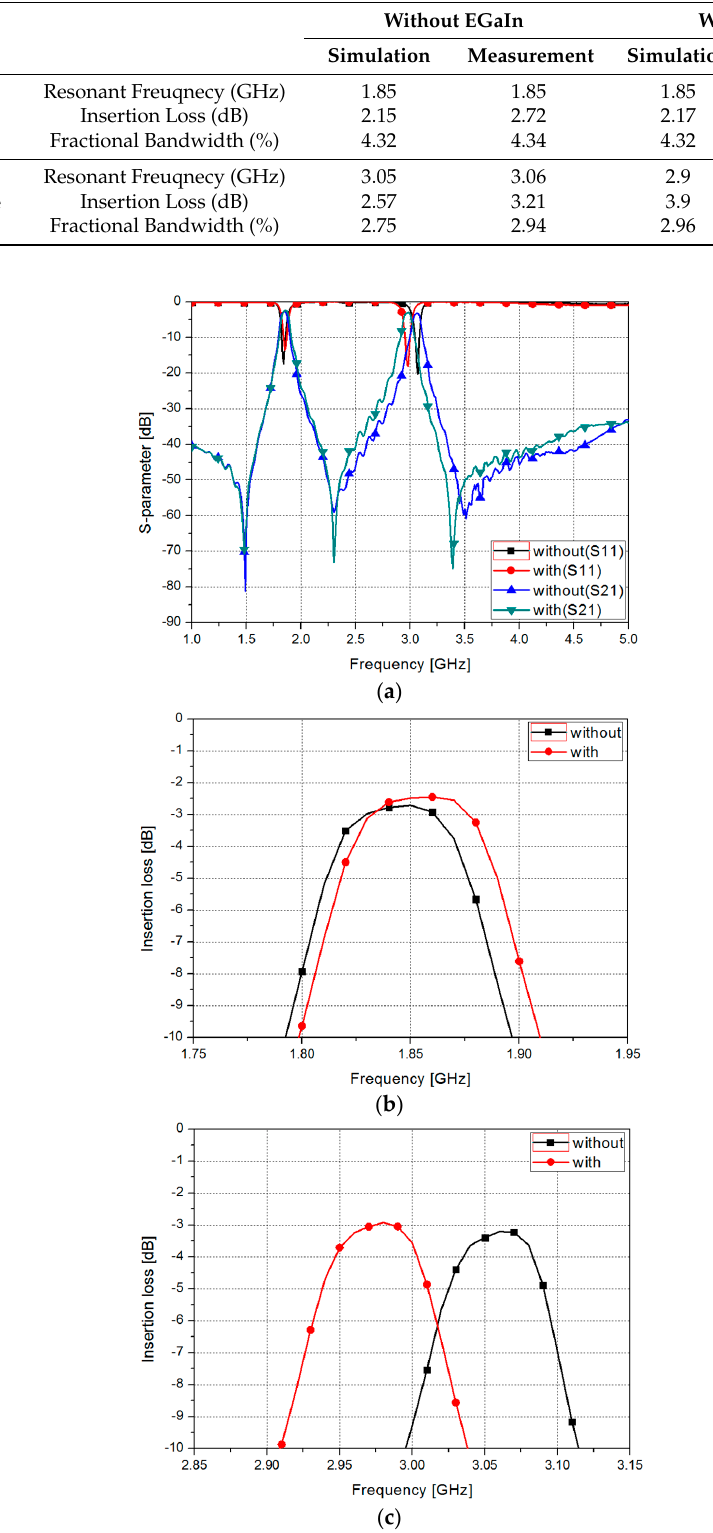
Figure 7. ( a ) Measured S-parameters of the proposed filter without and with EGaIn and insertion loss without and with EGaIn ( b ) in odd mode; and ( c ) in even mode.